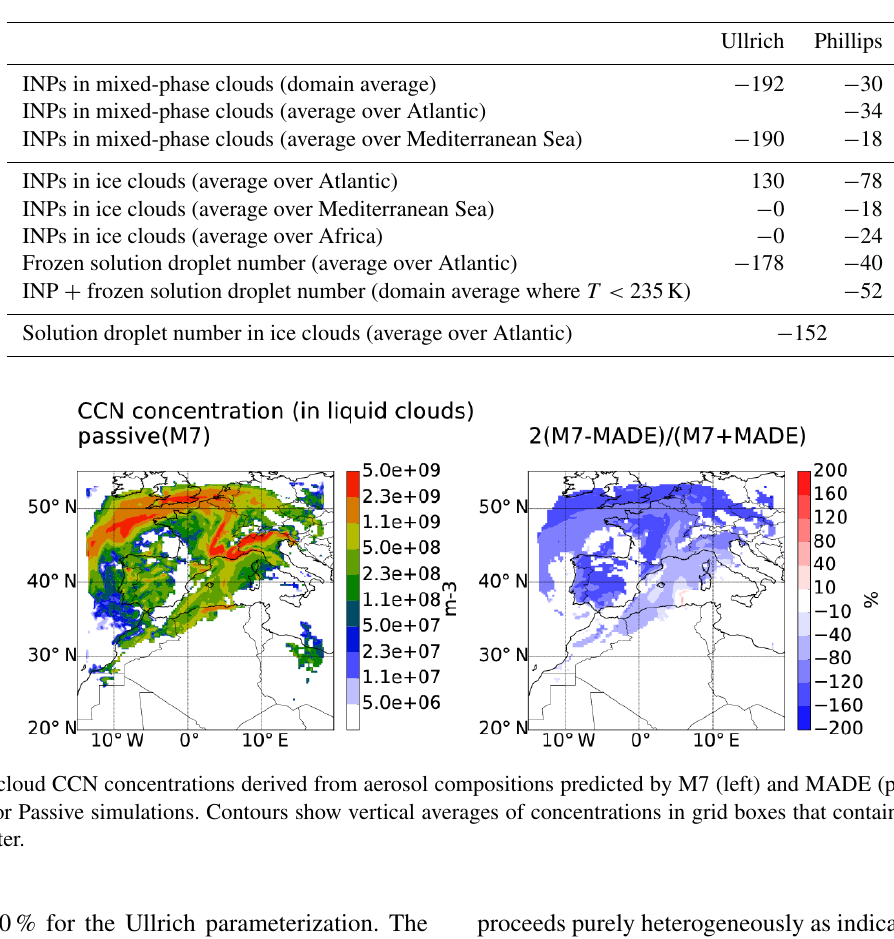
Table 8. Horizontal averages of relative differences (cid:49) = 2 ( M7 − MADE )/( M7 + MADE ) between MADE and M7 ice-nucleation properties in percent for Passive simulations with the Ullrich and Phillips ice-nucleation parameterizations. If not indicated otherwise domain averages are given. Values are based on vertically averaged concentrations and correspond to Figs. 12 and 13.